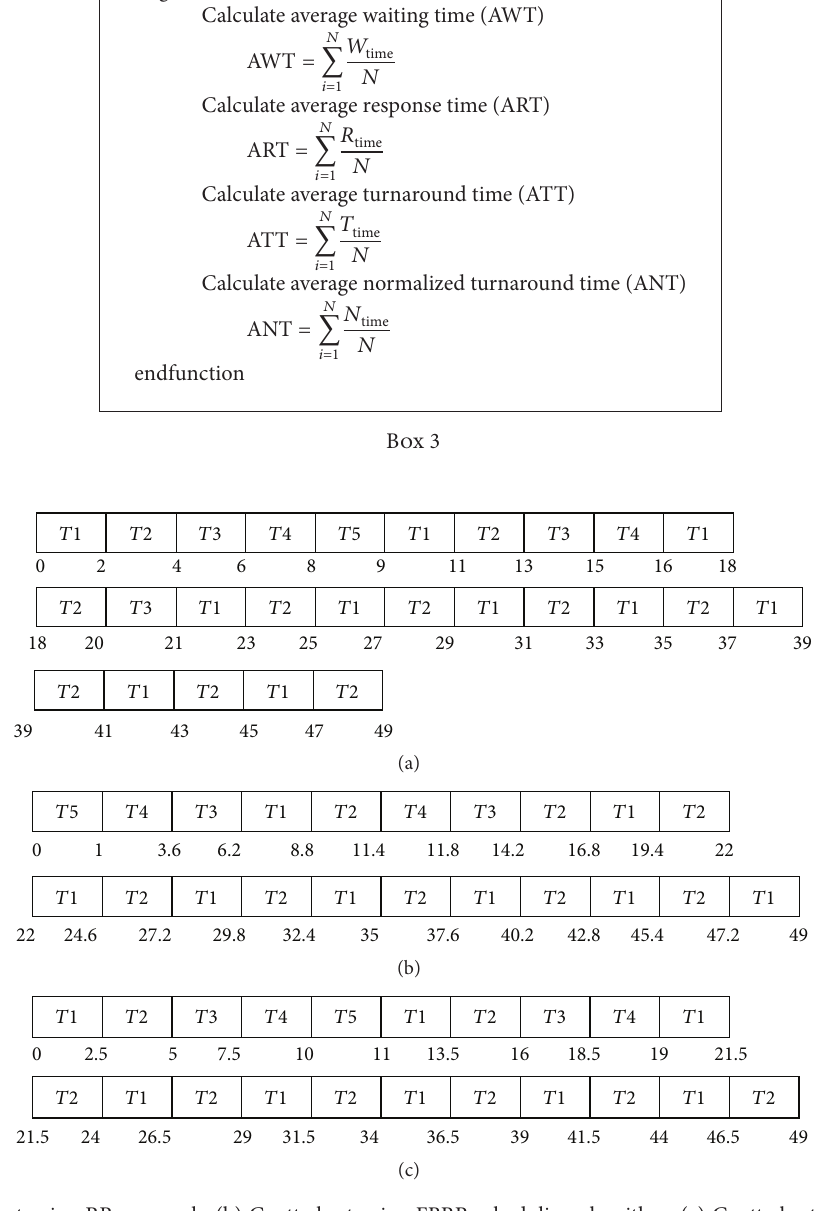
Figure 7: (a) Gantt chart using RR approach. (b) Gantt chart using FBRR scheduling algorithm. (c) Gantt chart using BFRR scheduling